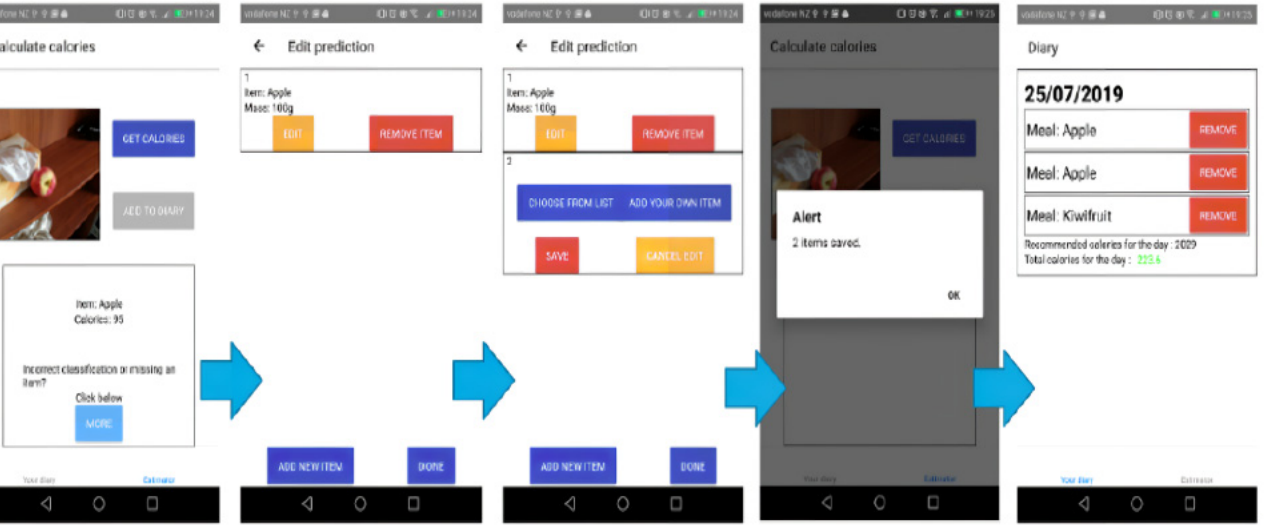
Table 3. Results from the real environment test. Authors